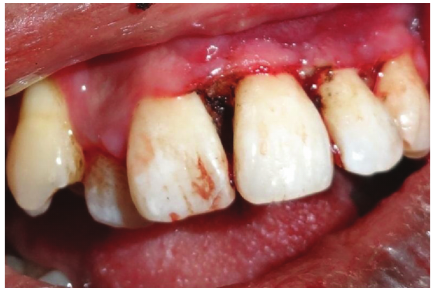
Figure 3: Immediate postoperative photograph.